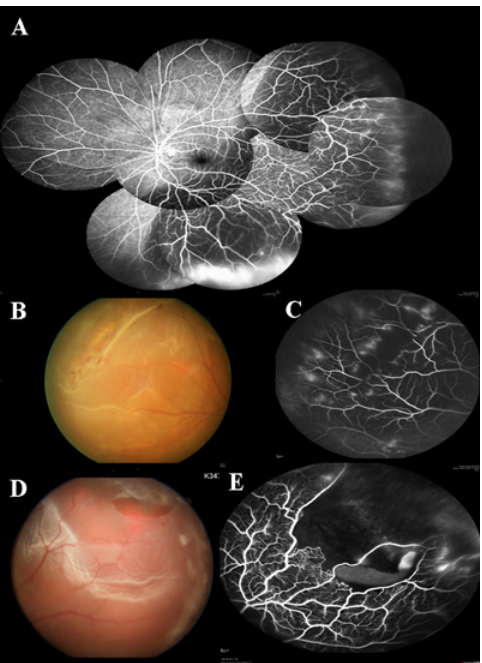
Fig 1. Color and FA pictures of group 1 eyes. (A) FA of an eye with group 1 retinal vasculature. Note there is a dichomatous ramified pattern of peripheral retinal vasculature with gradual tapering. Marked leakage